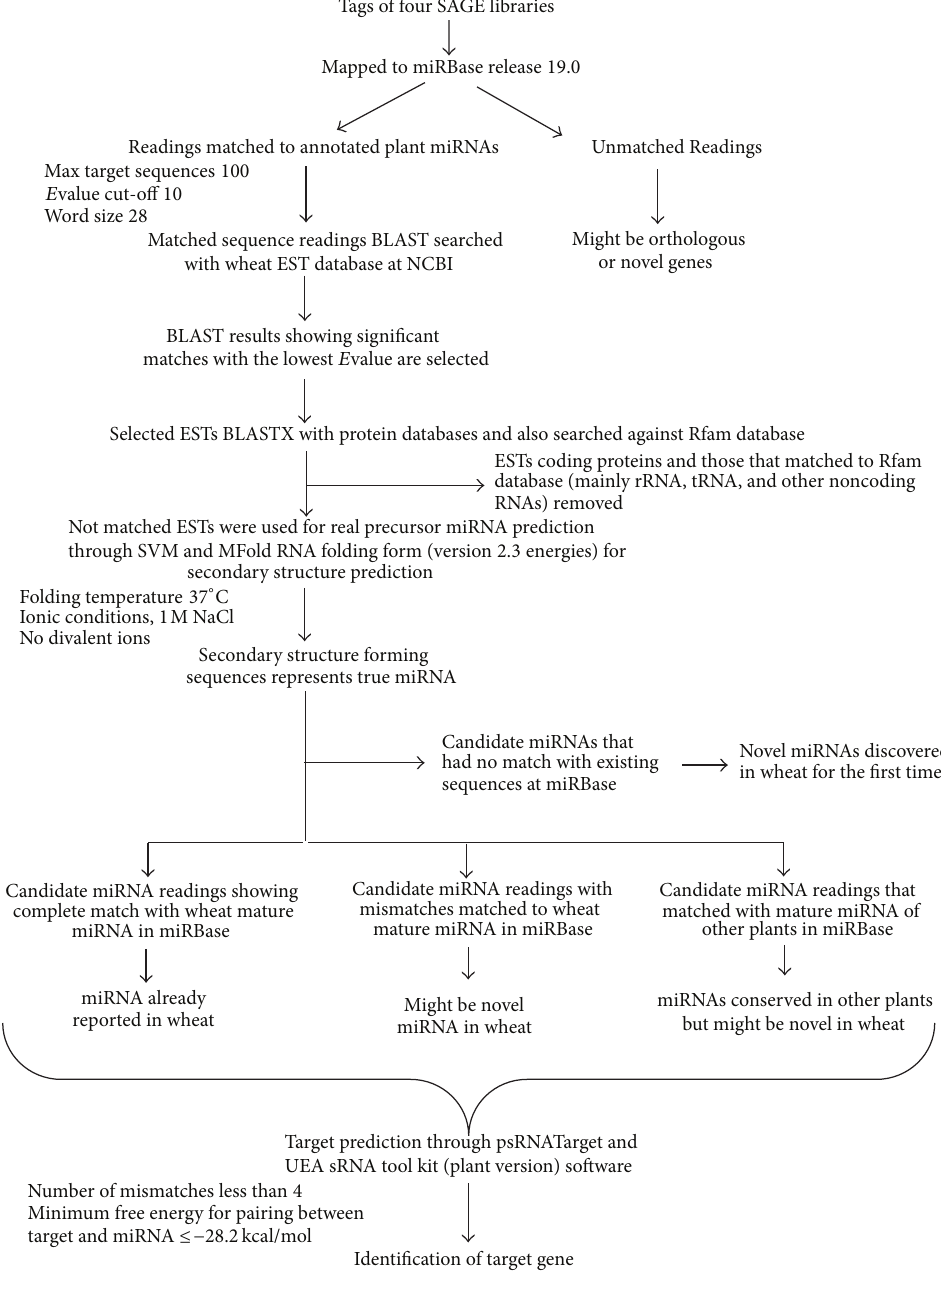
Figure 1: Schematic presentation of the pipeline developed to discover miRNA from NGS data and target prediction of miRNAs.